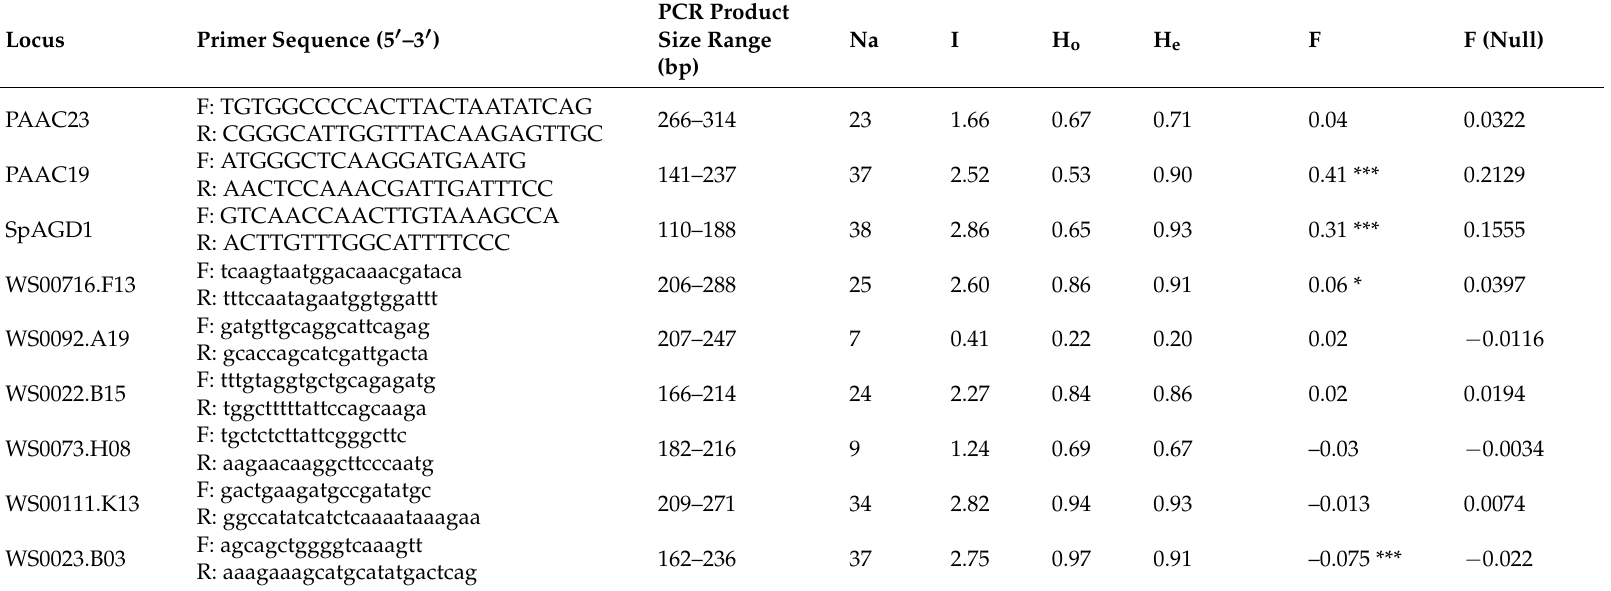
Table 2. Characteristics of selected nuclear microsatellite loci across 17 investigated Norway spruce